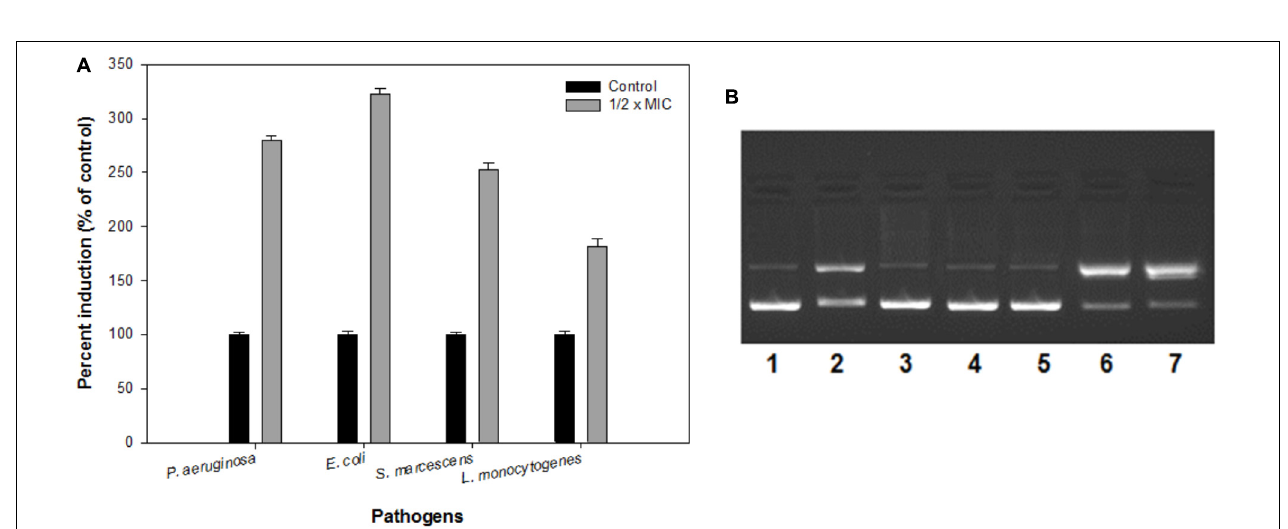
FIGURE 7 | (A) Reactive oxygen species (ROS) generation in the presence of IONPs using DCFH-DA as a ROS indicator. (B) The electrophoretic pattern is exhibiting nuclease activity of IONPs against pBR322 DNA for mechanistic pathways. [lane 1, DNA (100 ng) alone (control); lane 2, DNA (100 ng) + IONPs (10 µ M), lane 3, DNA + IONPs (10 µ M) + DMSO (1 mM); lane 4, DNA + IONPs + tBuOH (1 mM); lane 5, DNA + IONPs + NaN 3 (1 mM); lane 6, DNA + IONPs + D 2 O (1 mM); lane 7, DNA + IONPs + SOD (10